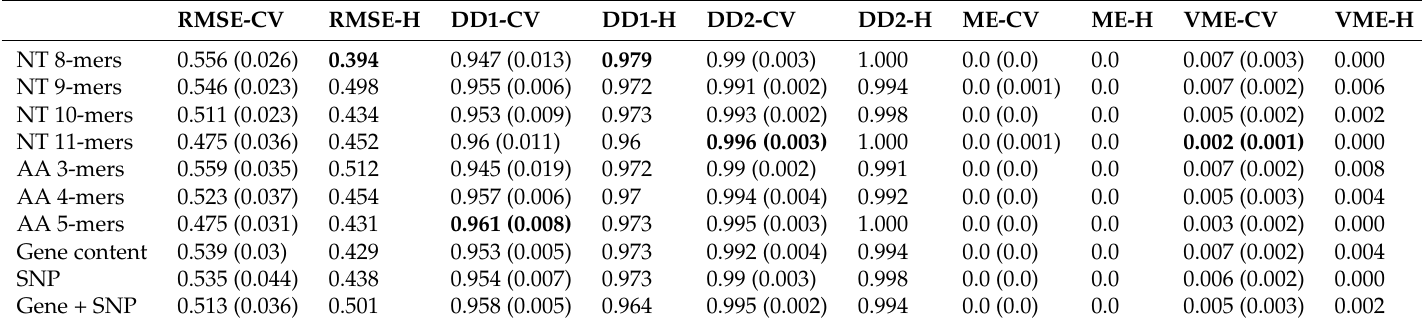
Table A60. S. enterica –nalidixic